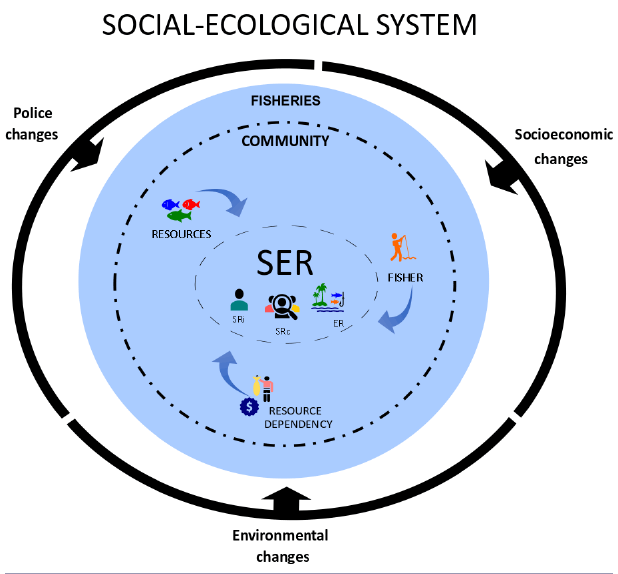
Fig. 1 . A conceptual framework for assessing the social- ecological resilience (SER) of small-scale fishers as a function of policy, environmental, and socioeconomic changes in the social-ecological system. SRi = Social Resilience at the individual level; SRc = Social Resilience at the community level; ER = Ecological Resilience. Adapted from Marshall et